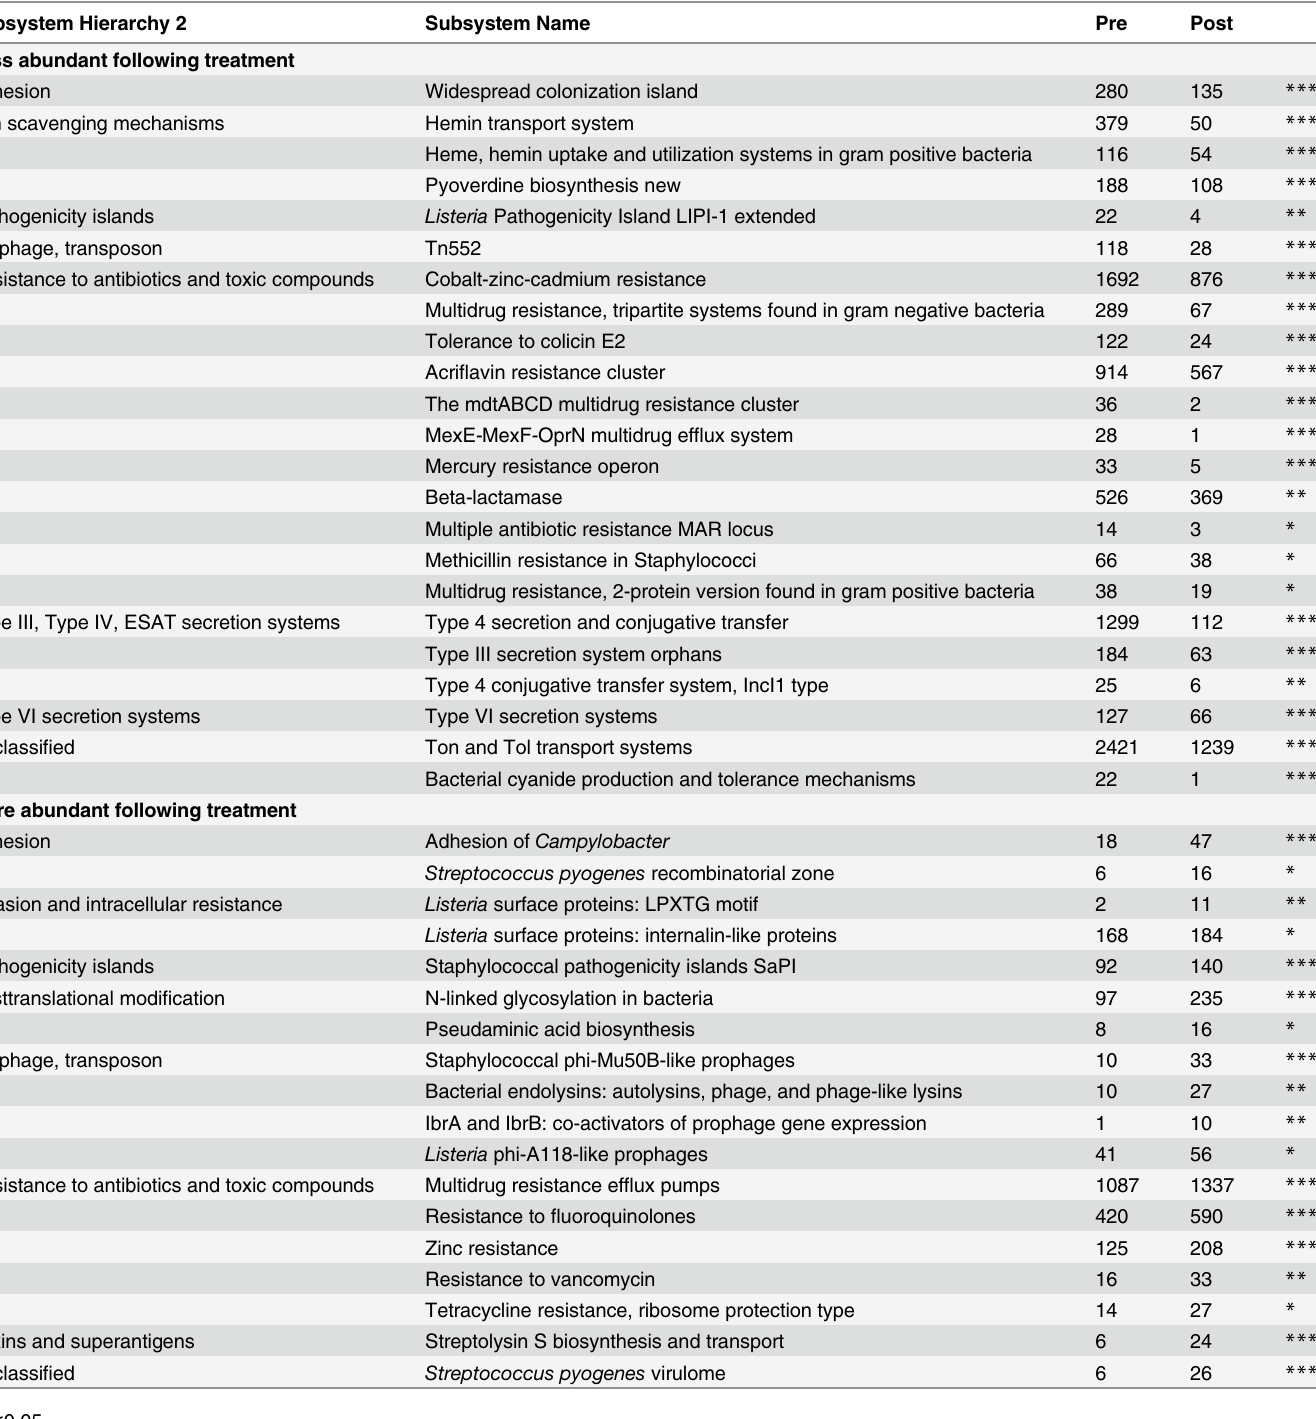
Table 7. Number of hits to related to virulence genes in the Plant A biosolids samples sampled on August 4, 2009.